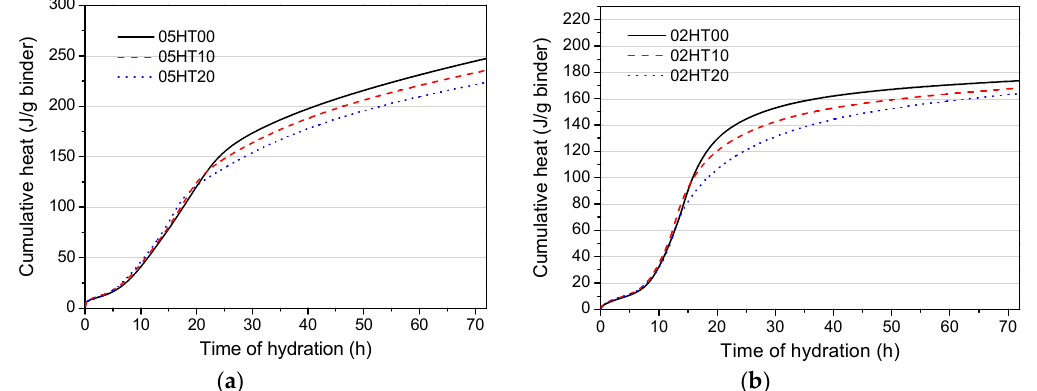
Figure 8. Cumulative heat of binder pastes normalized per gram of binder when ( a ) w/b = 0.5 and ( b ) w/b = 0.2. Figure 7. Hydration heat evolution of samples with w/b = 0.2. ( a ) Heat evolution rate. ( b ) Cumulative heat.